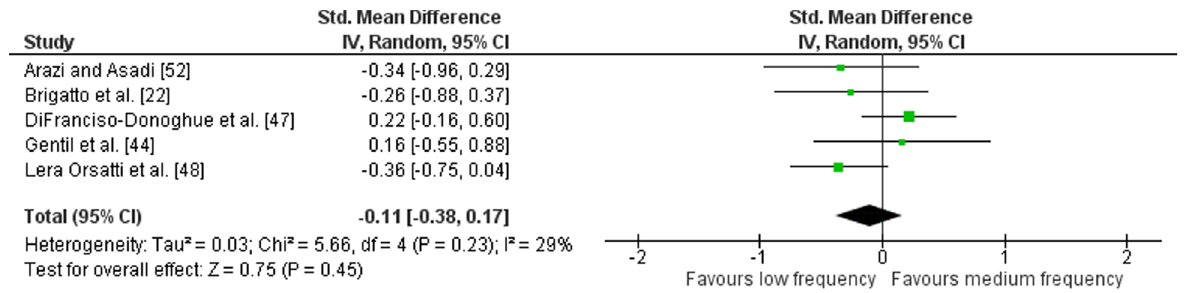
Fig. 6 Low vs. medium weekly training frequency. Pre- vs. post-mean ES strength difference on multi-joint and isolation exercises. The vertical line indicates the overall estimate of combined multi-joint and isolation studies pre- vs. post-mean ES strength difference. Horizontal lines indicate 95% CI, squares estimates, whereas square size is proportional to sample size, and rhombs ’ meta-analytically pooled estimates